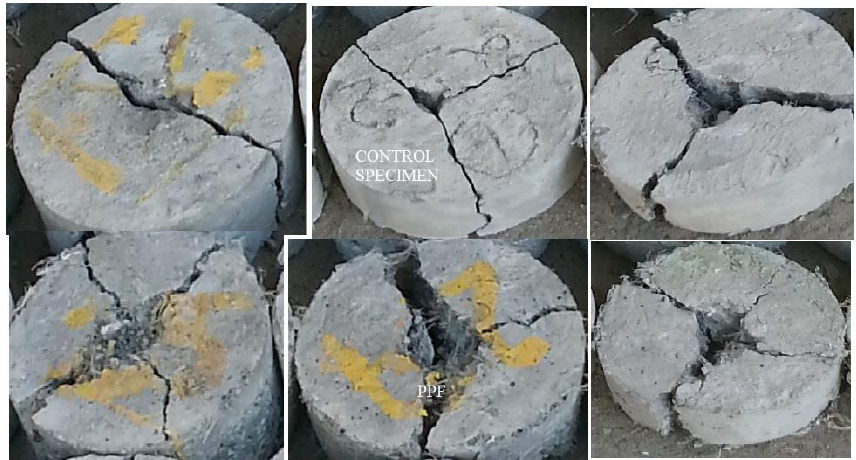
Figure 6. Different failure patterns of the tested